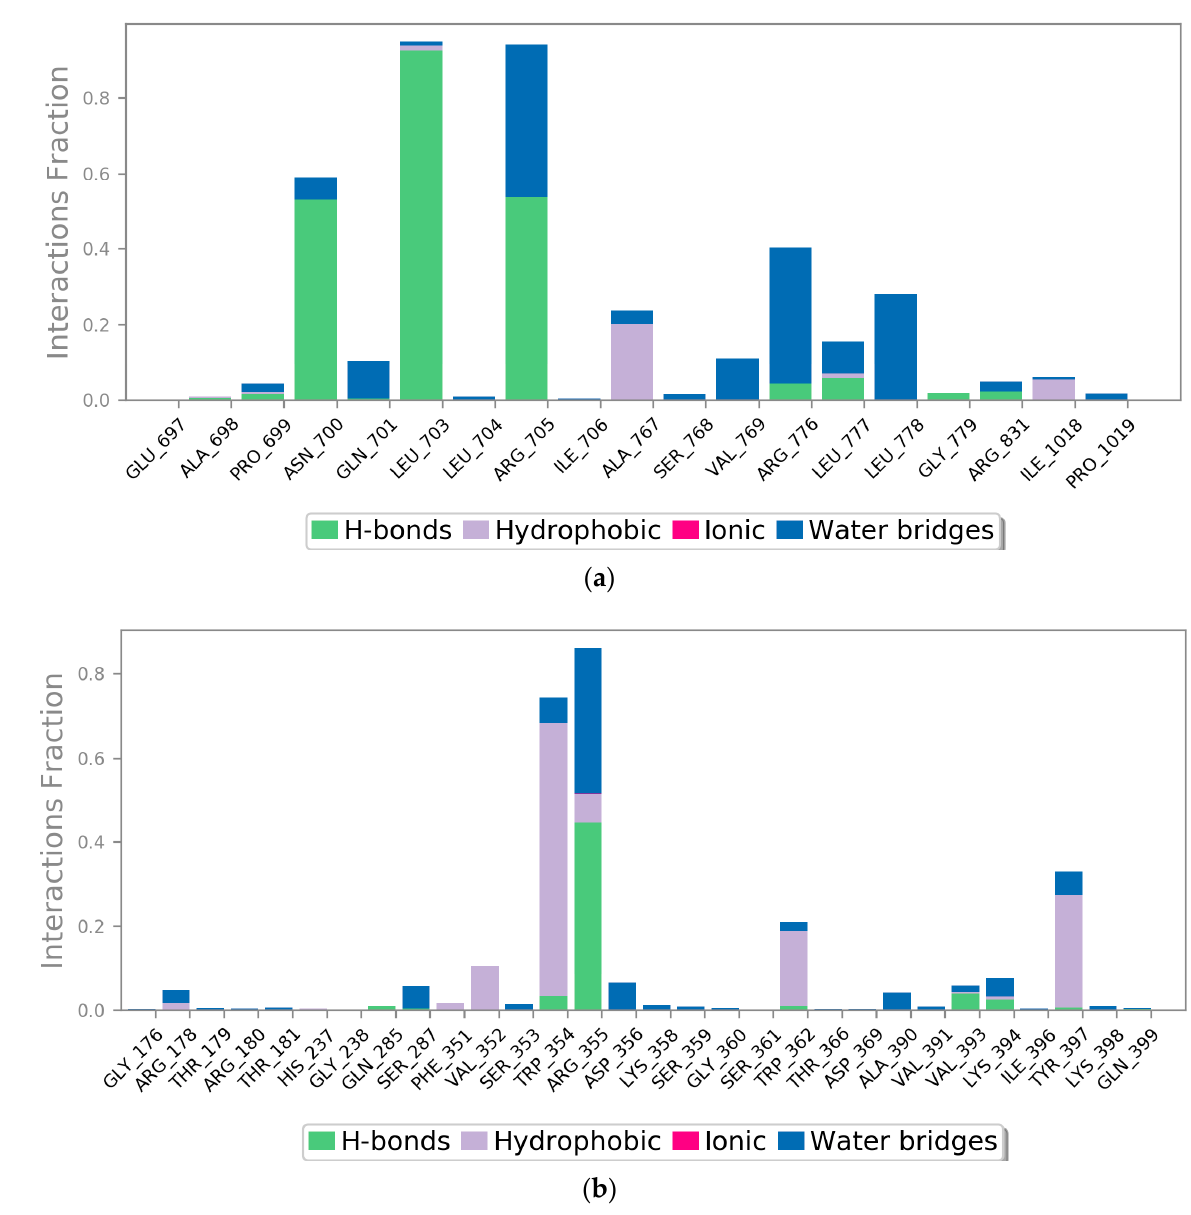
Figure 8. Protein–ligand contact histograms (hydrogen bonding, hydrophobic interactions, ionic interactions, and water bridges) of ( a ) EGFR-liquoric acid complex and ( b ) caspase-9-limonin complex.